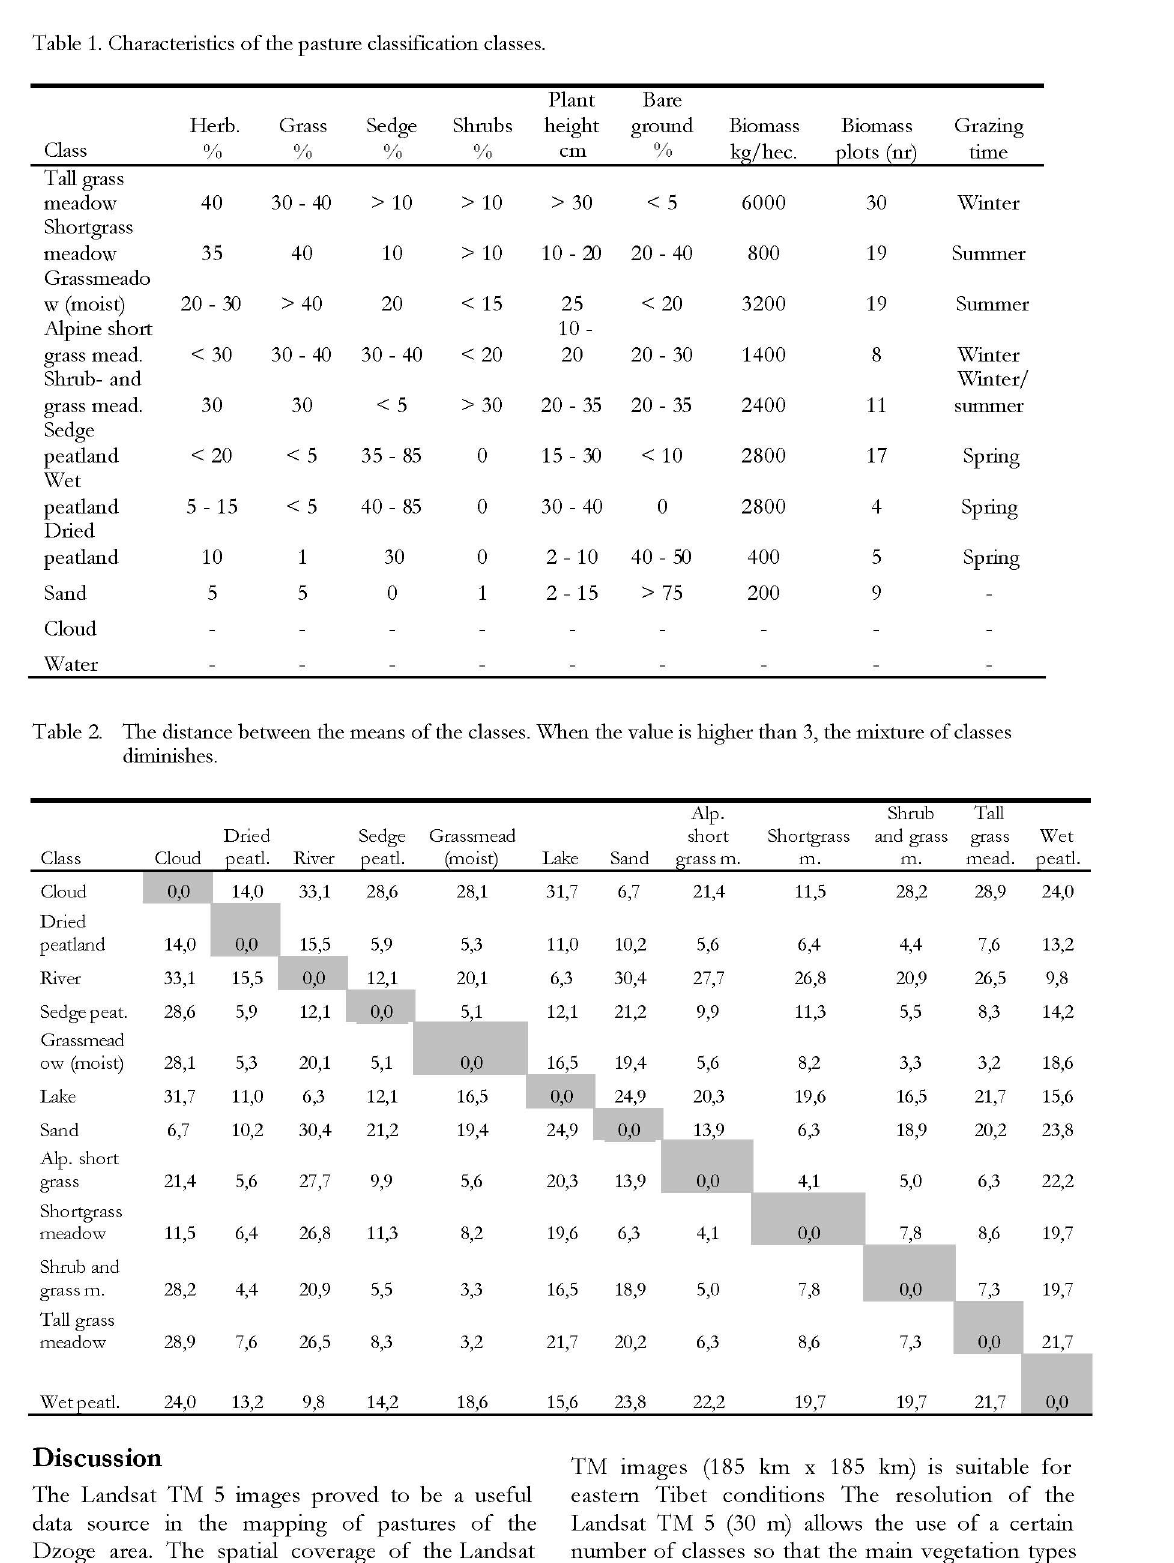
Table 1. Characteristics of the pasture classification classes.